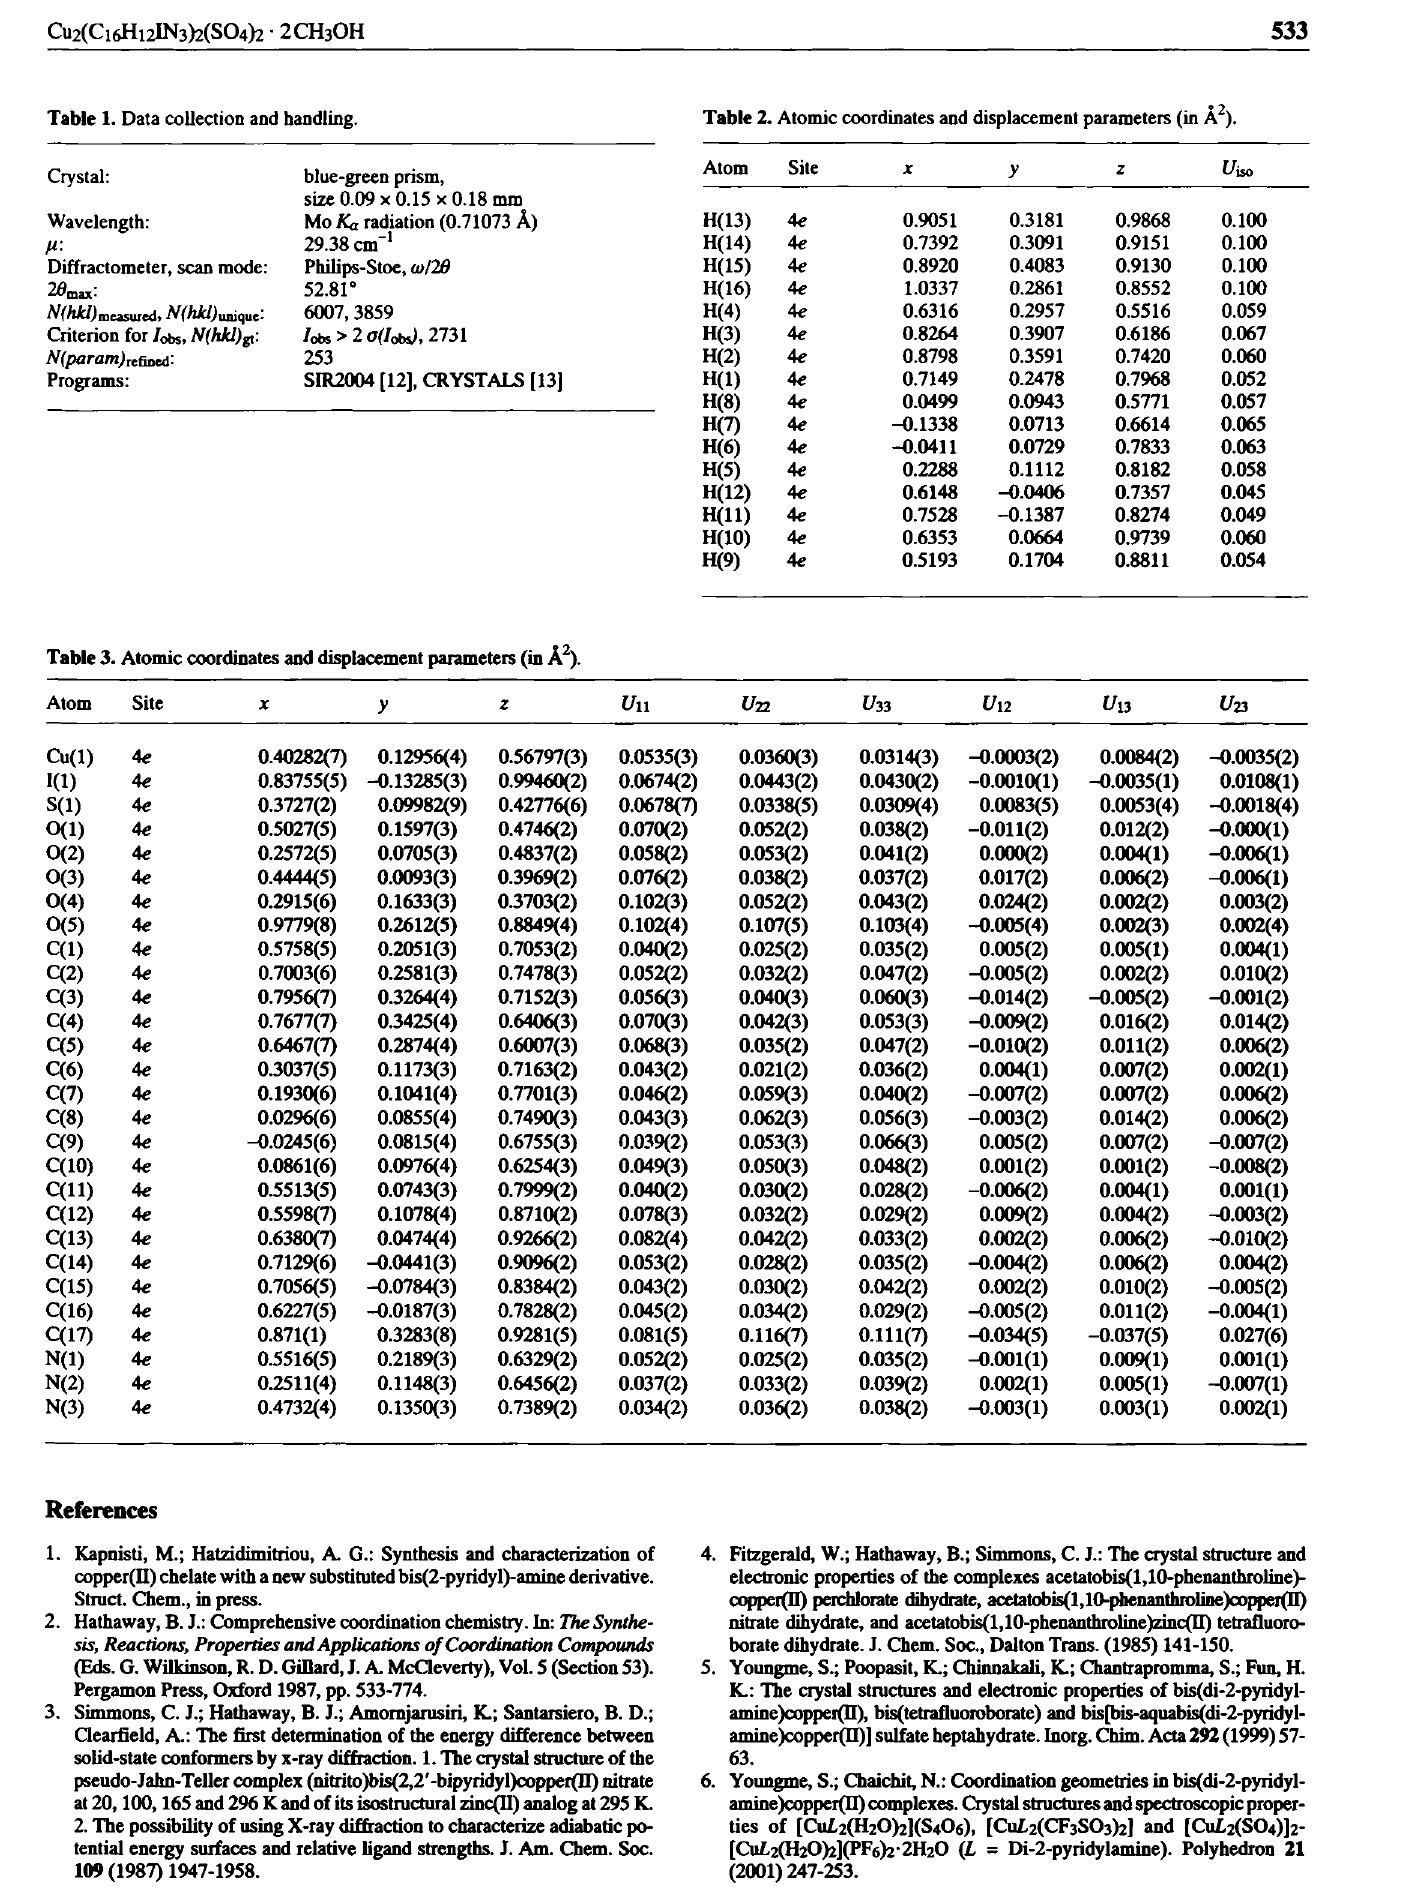
Table 3. Atomic coordinates and displacement parameters (in Ä 2